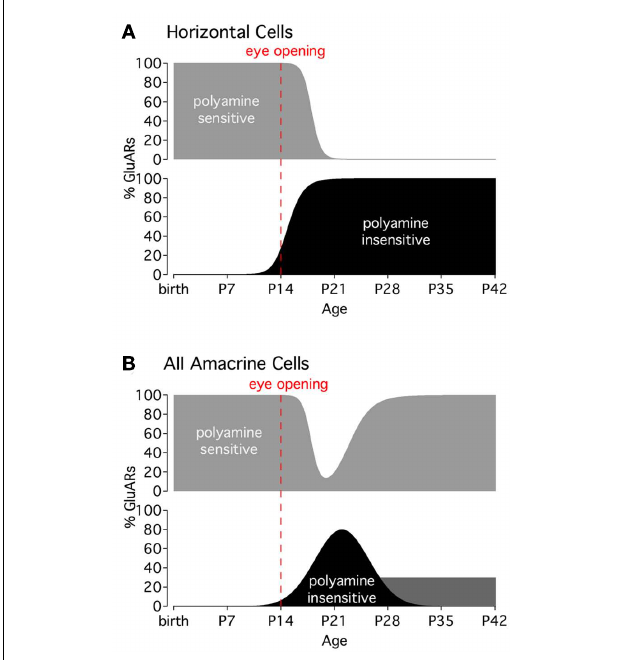
FIGURE 2 |Activity-dependent changes in CP-GluAR polyamine sensitivity. (A) CP-GluARs in horizontal cells become insensitive to polyamines around the time of eye opening (P14). (B) In AII amacrine cells, CP-GluARs occupying the ON portion of the IPL recover polyamine sensitivity about 2weeks after eye opening, whereas CP-GluARs in the OFF layer remain insensitive into adulthood (dark gray bar; Osswald et al., 2007). Graphs modified from Osswald et al.